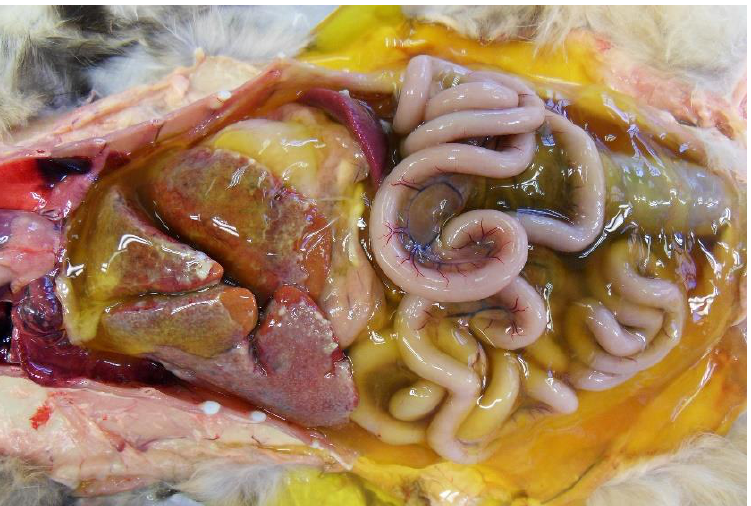
Figure 2. Cat abdominal cavity. Yellowish effusion filled peritoneal cavity. Surfaces of abdominal structures are covered with plaques of white granular material (fibrin).